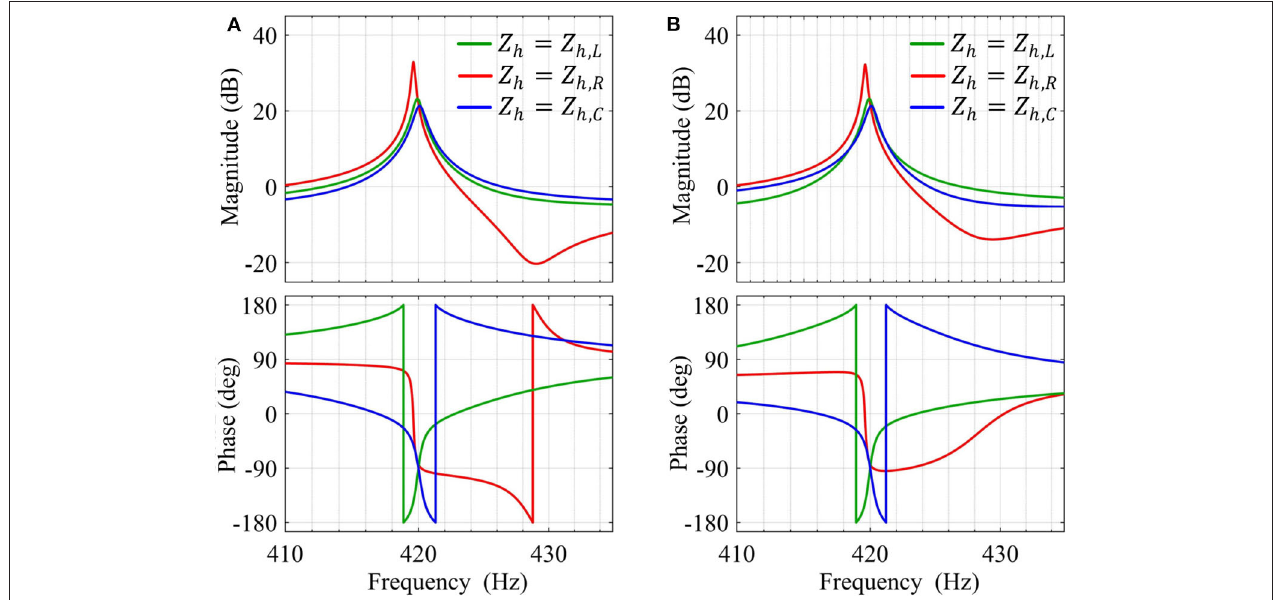
FIGURE 11 | Converter output impedance (zoomed in around harmonic order h impedance Z h ( s ) using converter-side current feedback, when— (A) R vir